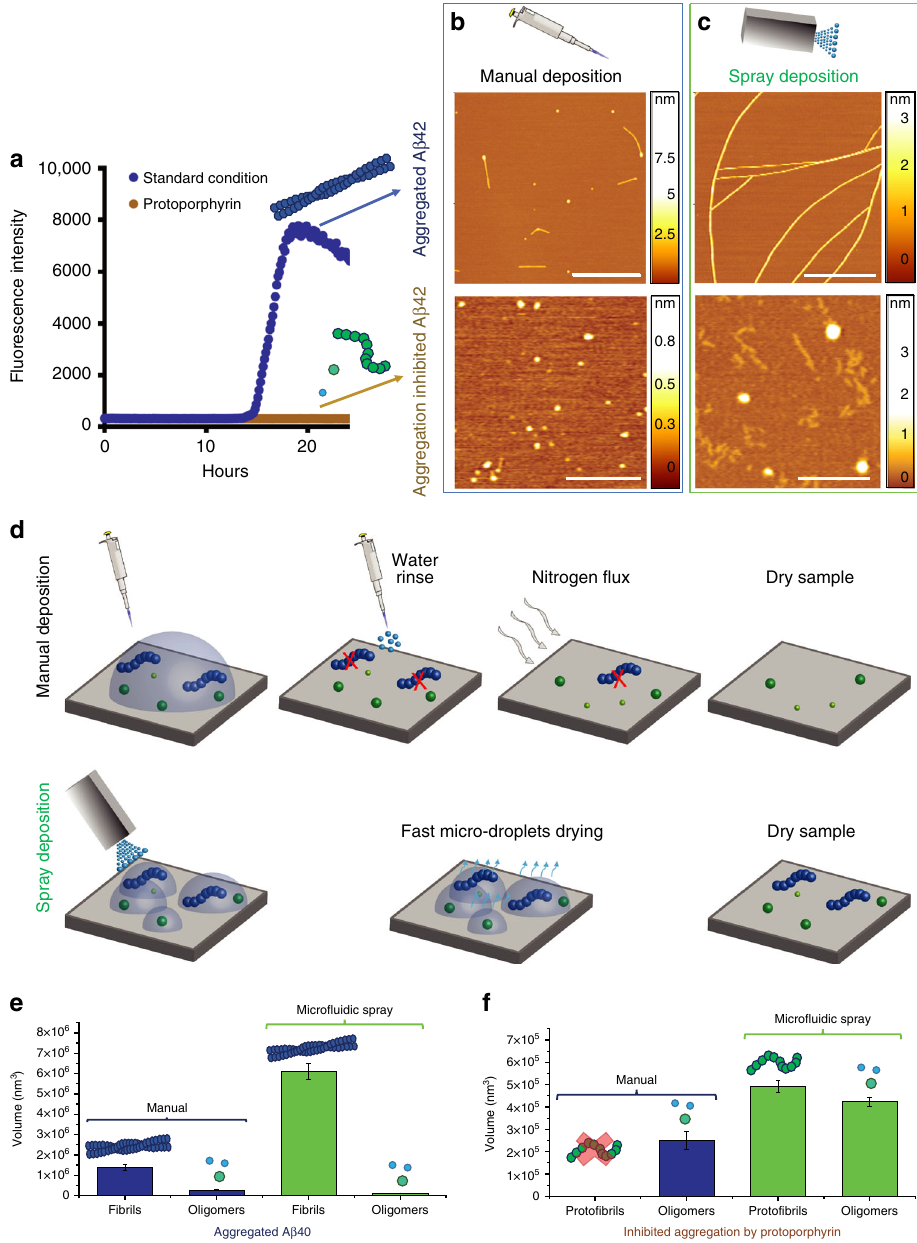
Fig. 5 Spray deposition avoids selective sample adsorption. a Kinetic pro fi les of the aggregation reaction of 10 μ M A β 40 under standard conditions (blue curve) and in the presence of protoporphyrin (Proto), which inhibits its aggregation (brown curve). Deposition of the fi nal products of the aggregation in the absence and presence of the inhibitor by ( b ) manual (scale bar: top image 1000 nm, bottom image 200 nm) and ( c ) automated spray deposition (scale bar: top image 1000nm, bottom image 200 nm). d Illustration of the differences between the two preparative methods and the effects leading to selective adsorption. Quanti fi cation of the absolute mass (values are mean ± s.d.) of coexisting amyloid species at the end of the aggregation reaction by measuring the volume of each species in ( e ) standard and ( f ) inhibited conditions of